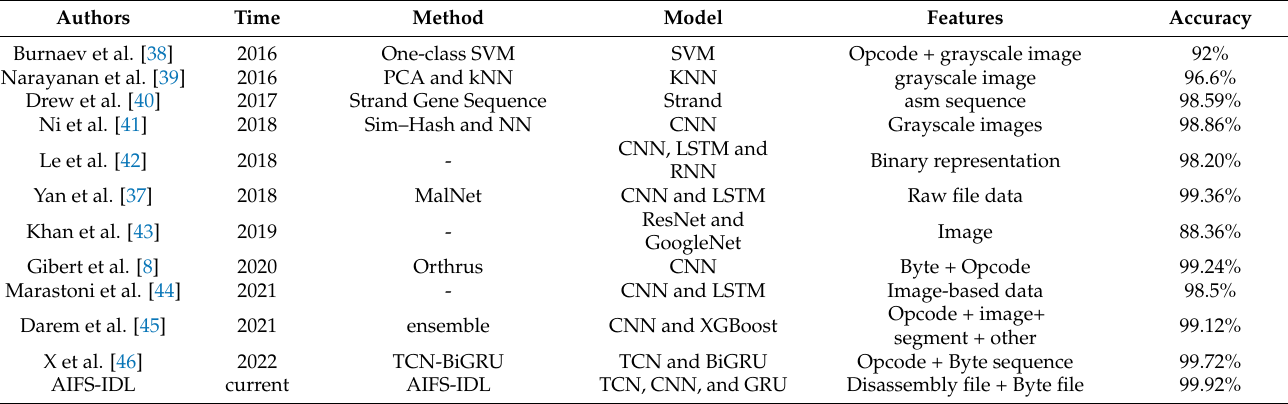
Table 6. Comparison with the existing